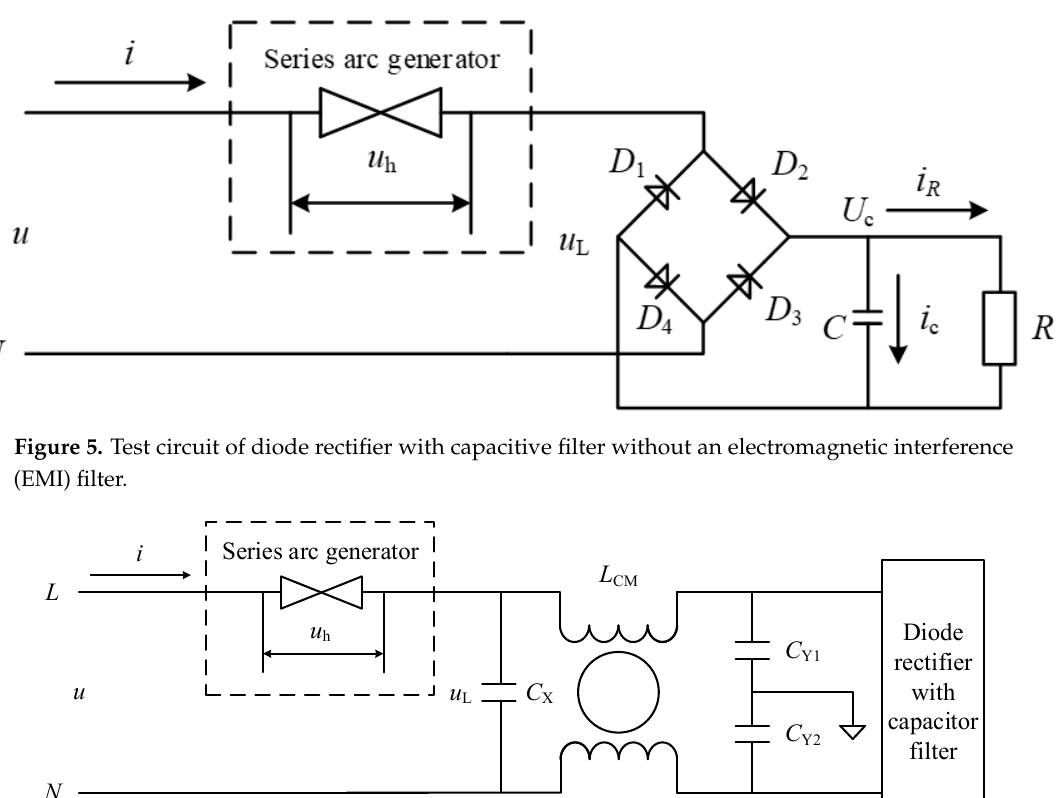
Figure 6. Test circuit of diode rectifier with capacitive filter and EMI filter.